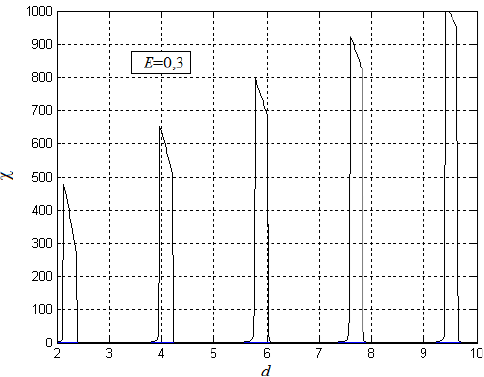
Figure 7: Change in permeability and selectivity with increasing distance between barriers